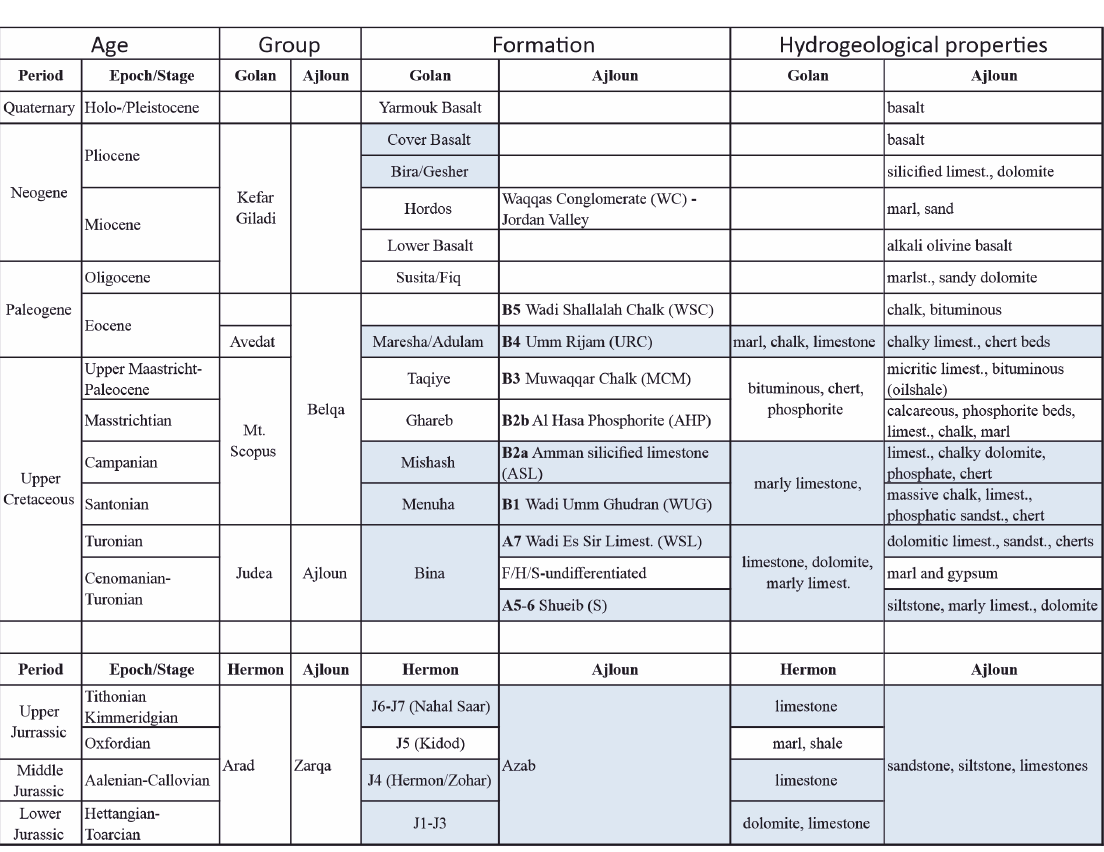
Figure 2. Stratigraphic table comparing the Israeli and Jordanian nomenclature. Aquiferous units are colored in blue after